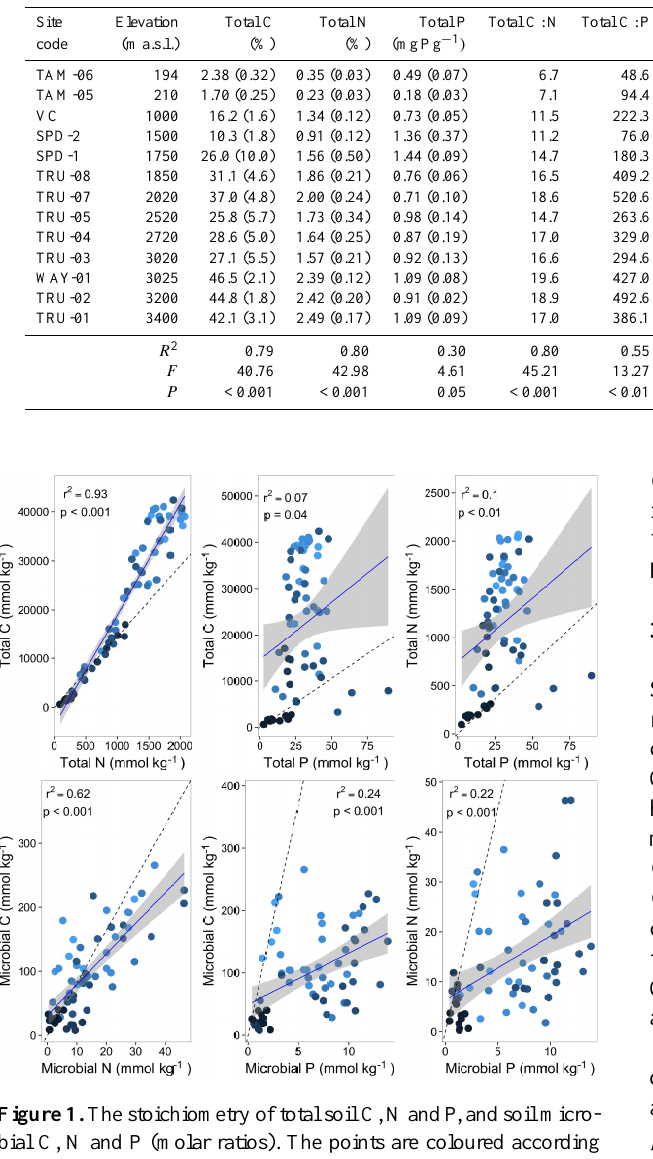
Table 2. Soil nutrients and pH along the elevation gradient. Linear model results (elevation ∼ property) are given at the bottom of the table. Values are means ± 1 SE ( n = 5).